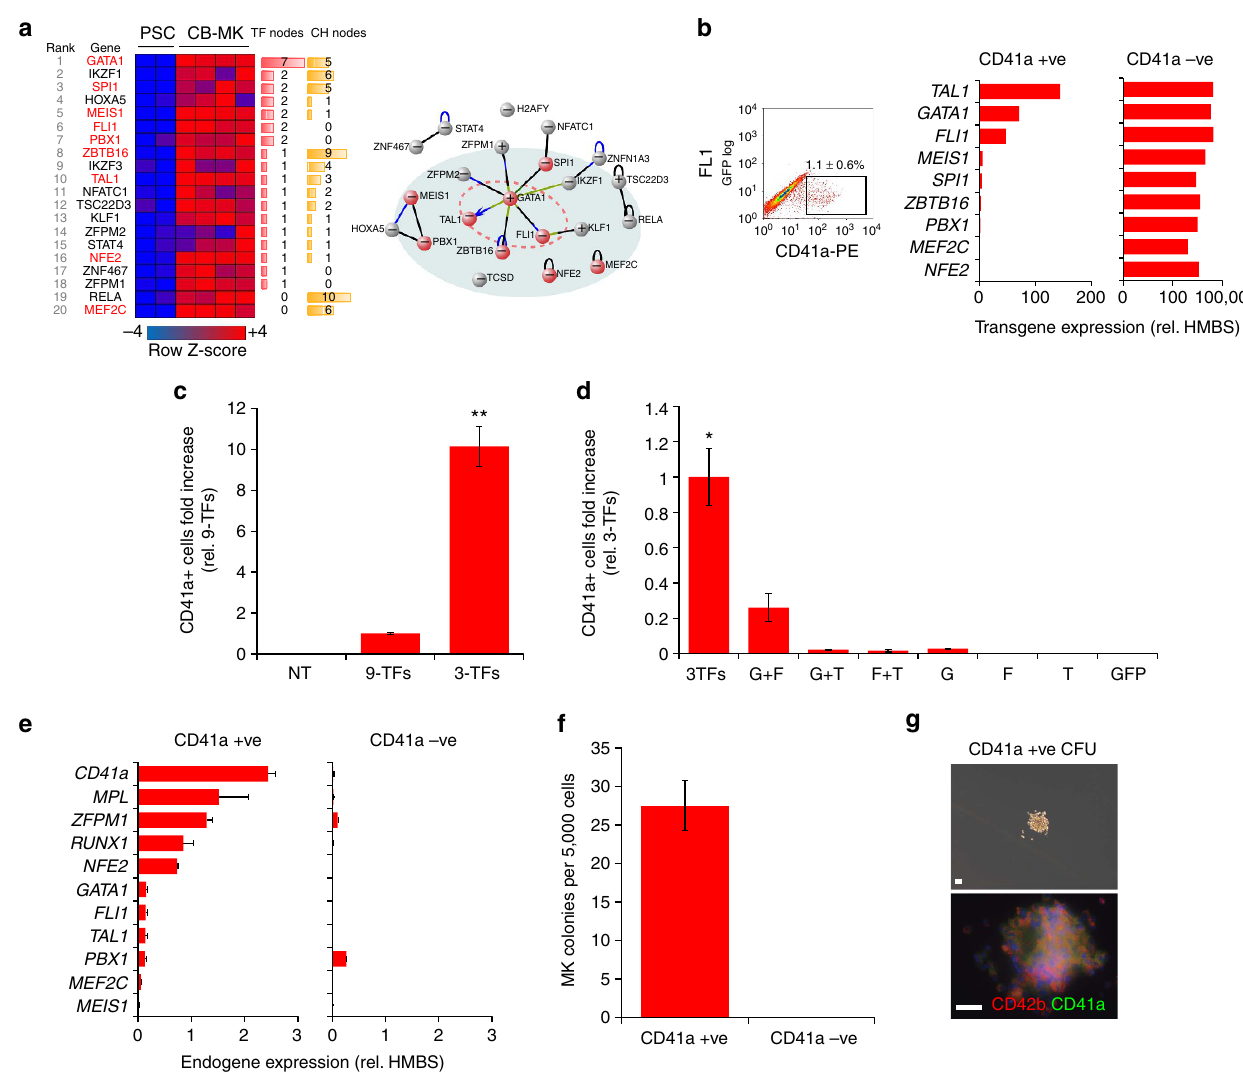
Figure 1 | TF candidate screening for MK forward programming. ( a ) TF expression in hPSCs versus cbMKs plotted as a row normalized heatmap with indications of recorded TF internal and chromatin modifiers node numbers and protein interactions among the top 20 TF candidates reported by VisANT. The nine experimentally tested TFs are highlighted in red. ( b ) The H9 hESC line was concurrently transduced with the 9-TFs and maintained in pluripotency medium (FGF2 þ Activin-A) for 2 days followed by MK medium (TPO þ SCF) for a further 5 days. CD41a þ cells generated 7 days after lentiviral transduction (dot plot, mean% ± s.e.m., n ¼ 5; FL1: 530/40nm channel) were sorted by flow cytometry and transgene expression levels quantified by RT-qPCR ( n ¼ 1). ( c ) The percentage of CD41a þ cells was monitored by flow cytometry 7 days after transduction of the hiPSC lines #1 and #2 with the 9-TFs or 3-TFs combination. Bar graphs represent the fold increase of CD41a þ cell count relative to the 9-TFs combination (mean ± s.e.m., n ¼ 4; ** P o 0.01 by two-tail t -test). NT: non-transduced cells. ( d ) The hiPSC#1 line was transduced with all permutations of the 3-TFs and percentages of CD41a þ cells measured by flow cytometry at day 7. Bar graphs represent the fold increase of CD41a þ cell count relative to the 3-TFs combination (mean ± s.d., n ¼ 2; * P ¼ 0.06 and P o 0.01 versus G þ F and other combination respectively by two-tail t -test). G: GATA1, F: FLI1, T: TAL1, GFP: control vector. ( e ) The endogenous expression of key MK genes was monitored by RT-qPCR from CD41a flow sorted cells 7 days after transduction of the hiPSC lines #1 and #2 (mean ± s.d., n ¼ 2). ( f ) The hiPSC lines #1 and #2 were transduced with the 3-TFs and sorted by flow cytometry for expression of CD41a at day 7. The clonogenic potential of sorted cells was tested in methylcellulose semi-solid medium supplemented with TPO and SCF. The number of colonies per 5,000 sown cells was determined after 10 days from duplicate wells (mean ± s.e.m., n ¼ 4). ( g ) A representative MK colony obtained from a CD41a þ cell co-expressing CD41a and CD42b as detected by immunofluorescence is shown (scale bar, 50 m